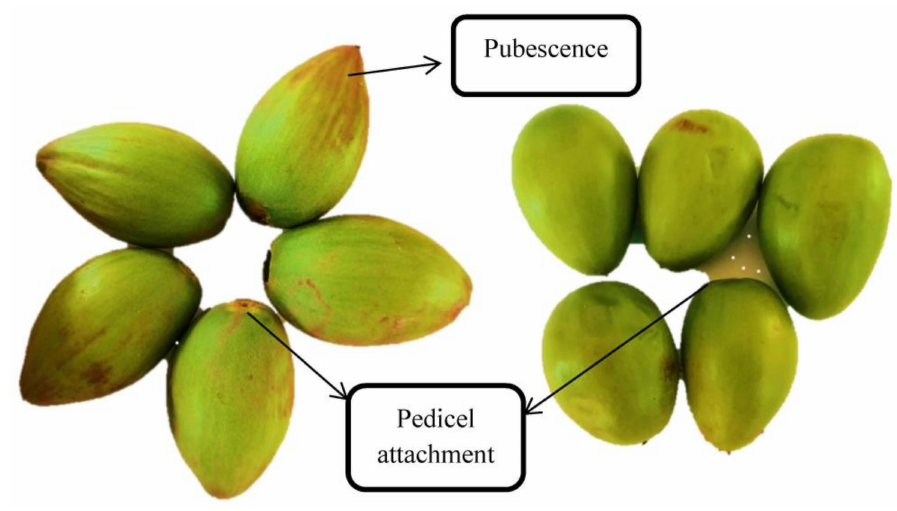
Figure 4. Inverted ovoid shea fruits showing pedicel attachment point and